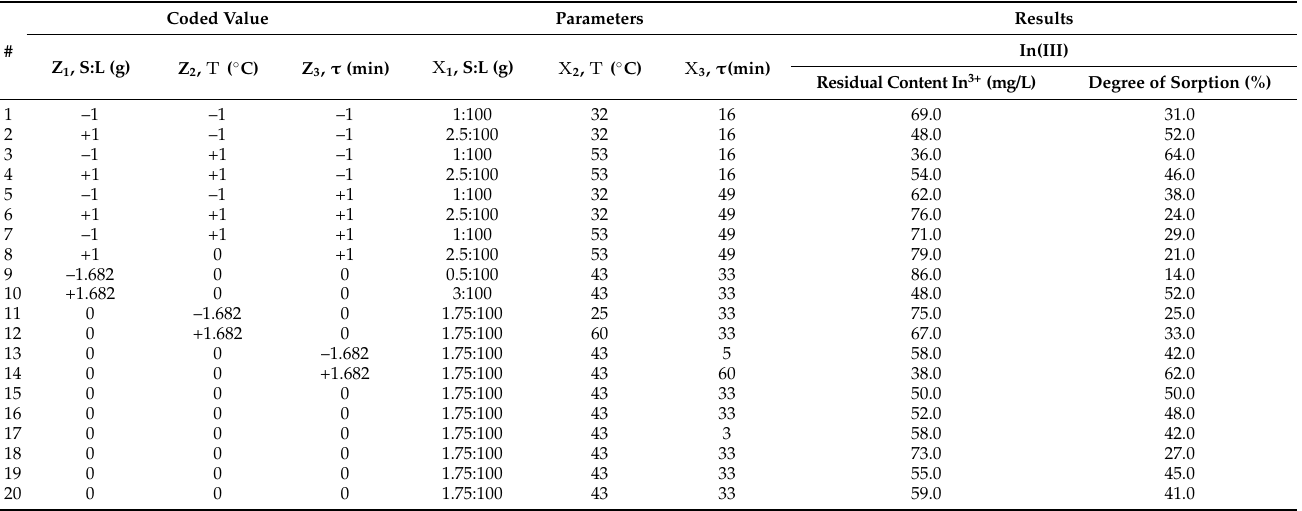
Table 2. The output parameters of the experiment on the sorption of the In(III) cations in the “natural zeolite-In 3+ -H 2 O”